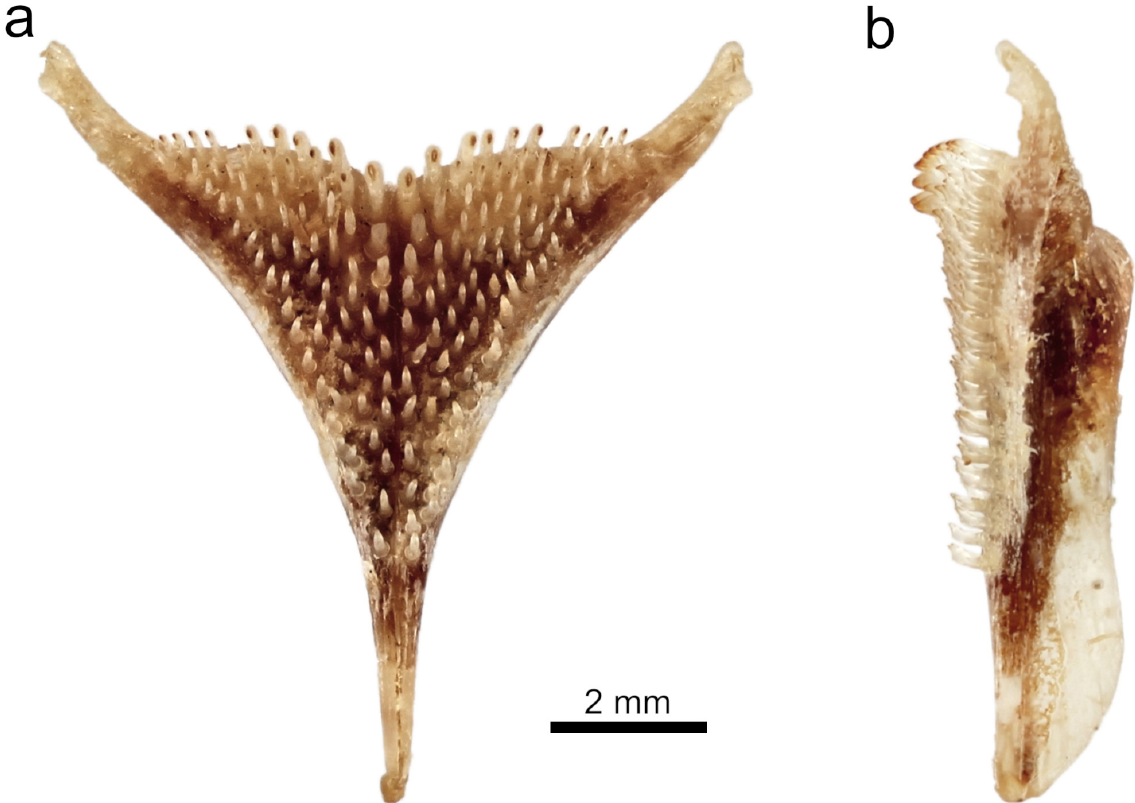
Fig. 34. Haplochromis pardus sp. nov. (RMCA 2016.035.P.0207; 96.1 mm SL). a . Dorsal view of the lower pharyngeal jaw. b . Lateral view of the lower pharyngeal